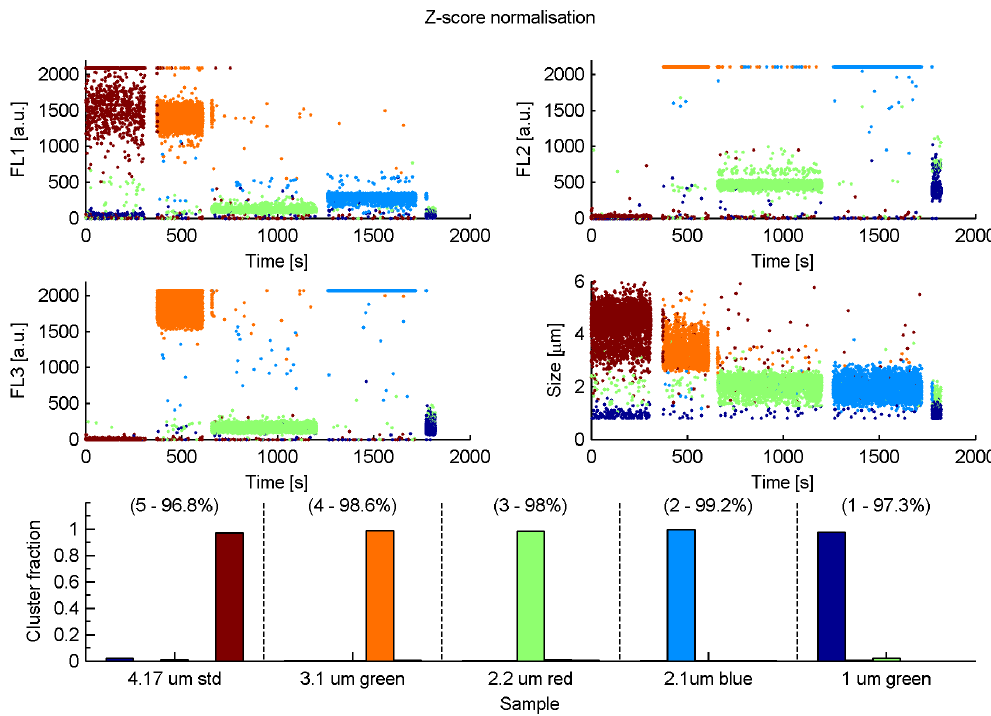
Figure 4. Same as Fig. 3 but for Ward linkage and z -score normalisation.